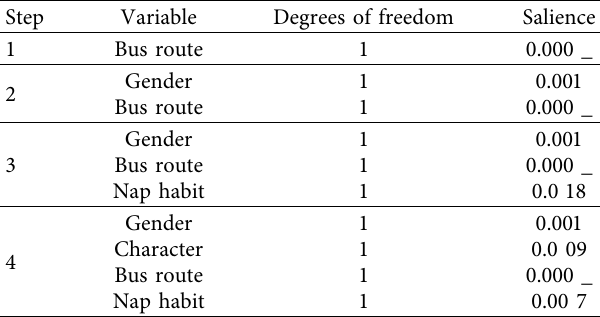
Table 18: Model (if item is removed).